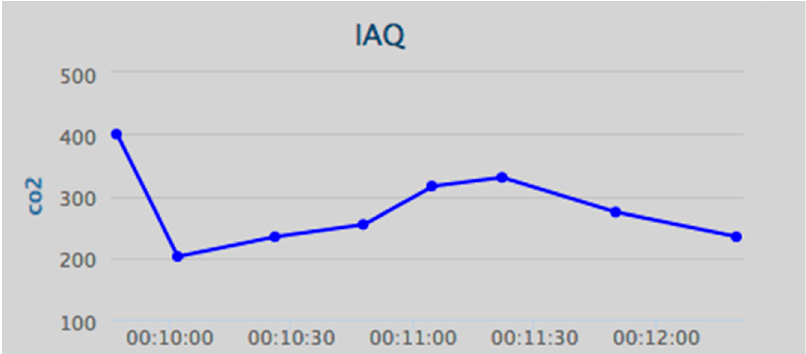
Figure 11. Data visualization: carbon dioxide (CO 2 ) concentration (ppm).